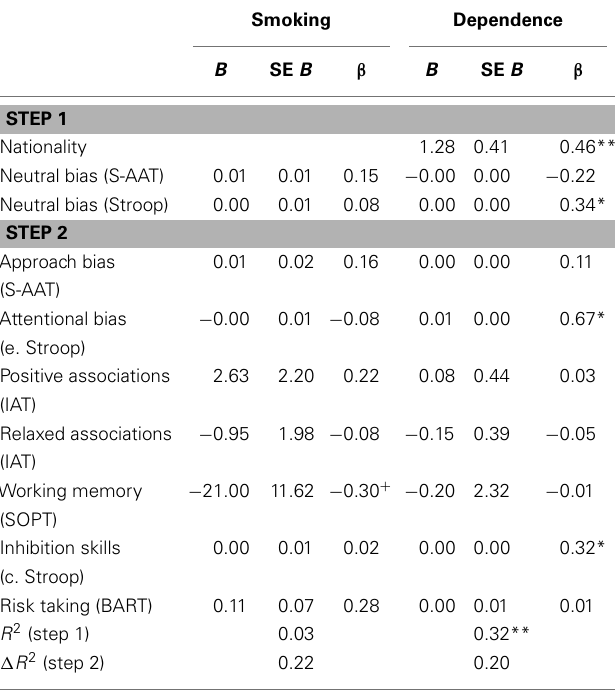
Table 2 | Hierarchical multiple regression analyses predicting daily cigarette use and nicotine dependence within the group of smokers